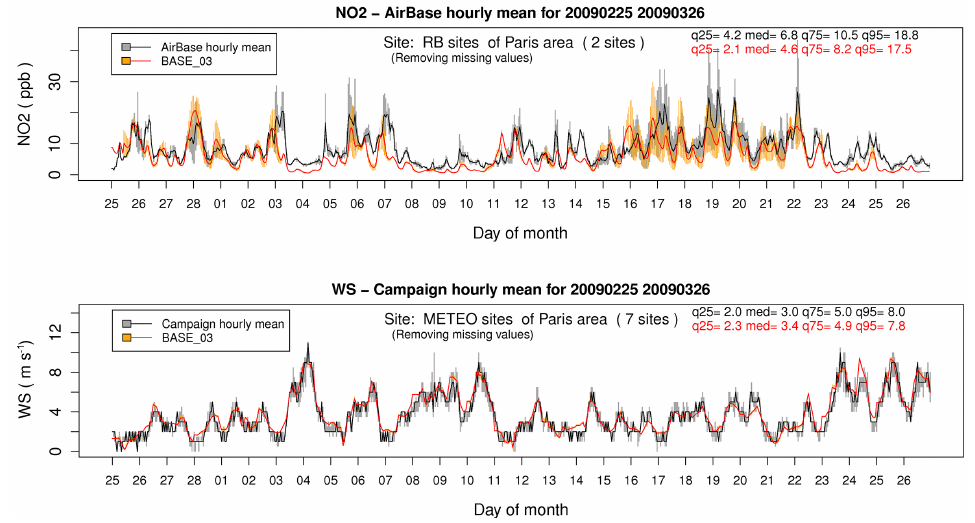
Figure 18. Time series of hourly box plots showing the distribution of the observed and computed NO 2 concentration (top) and wind speed (bottom) for CAMx (meteorology from IFS). Observations are in black/grey; modelled values in red/orange. Bars show the 25–75th quantile interval, while the median is displayed by the continuous line. The 25, 50, 75 and 95th quantiles of the whole campaign are reported, too. Comparison of computed and observed box plot time series is evaluated at AirBase and meteorological sites available over the Paris area.